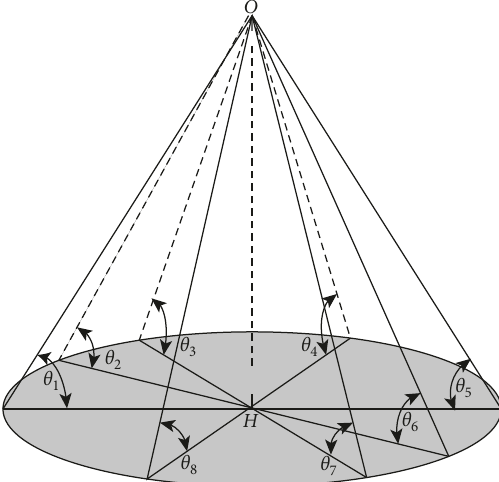
Figure 3: Schematic diagram of the measurement of angle of